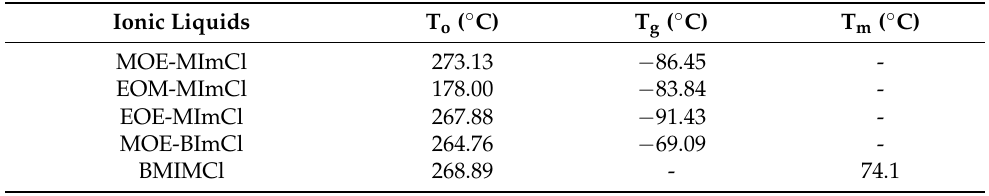
Table 2. Onset, glass transition and melting temperature for ILs.